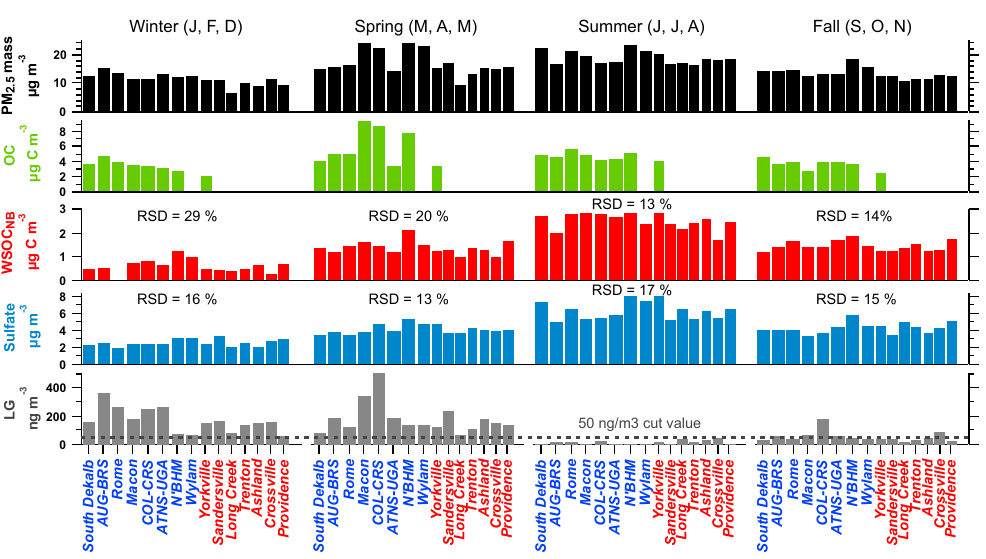
Fig. 2. Seasonal mean concentrations of (a) PM 2 . 5 mass, (b) OC, (c) WSOC NB , (d) sulfate and (e) levoglocosan (LG) for all 15 FRM sampling sites. OC data are only available at 7 of the 8 urban sites and 1 rural site. RSD stands for seasonal average relative standard deviations of WSOC NB and sulfate data. The initials after each season indicate the months included. Urban sites are labeled in blue and rural sites are labeled in